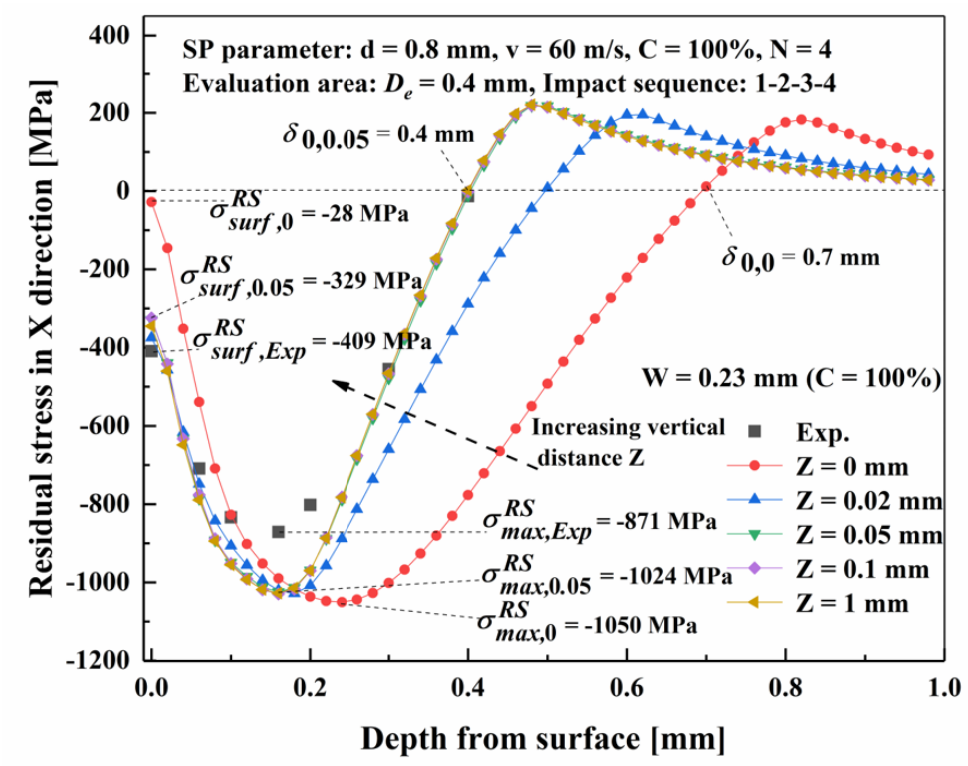
Figure 5. The residual stress depth profiles of five different vertical distance between shots (Z) SP models in the condition of V = 60 m/s, d = 0.8 mm and C = 100%.